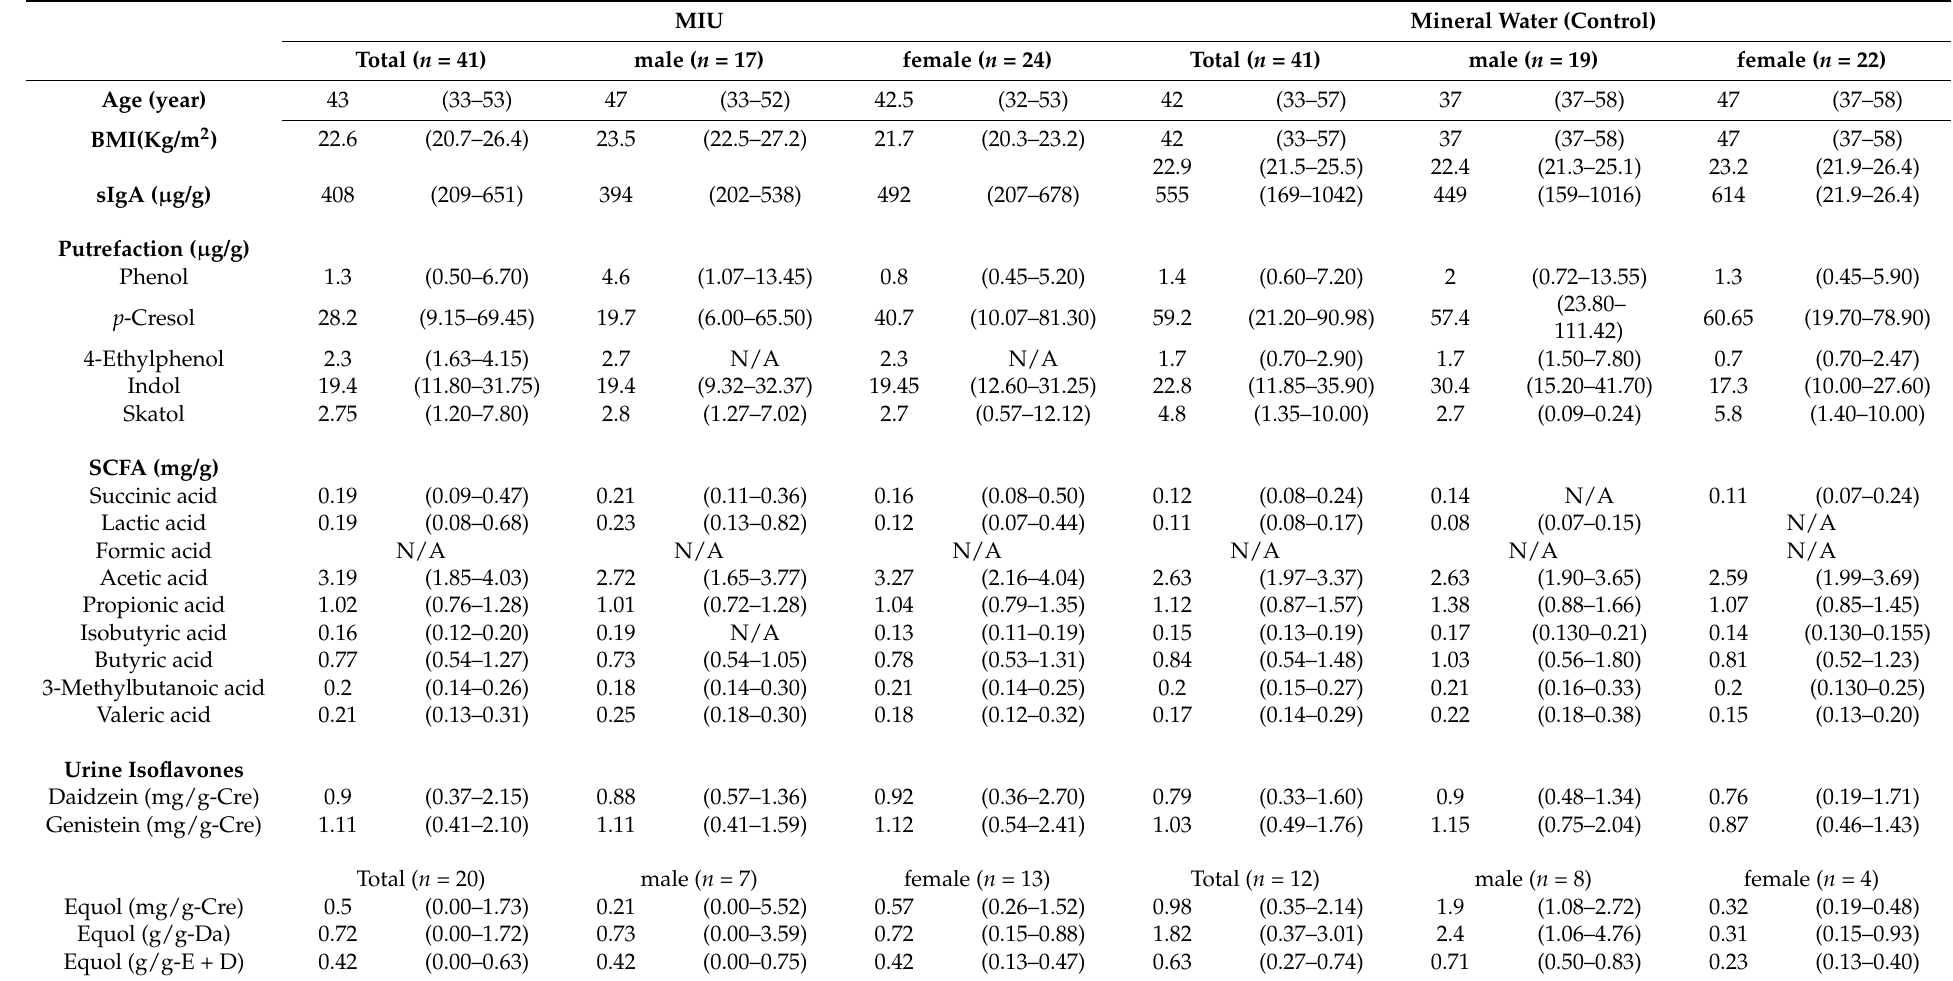
Table 1. Preintervention characteristics of the participants from the 2